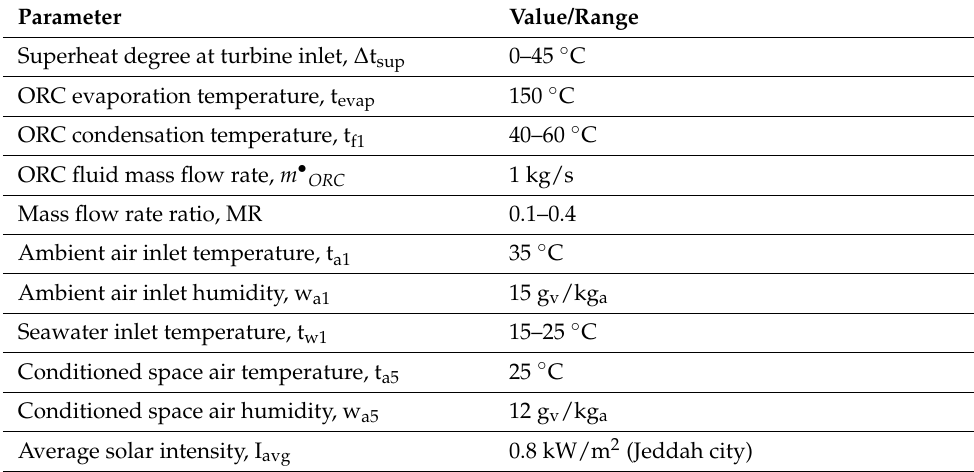
Table 1. Studied operating parameters, values, and ranges.